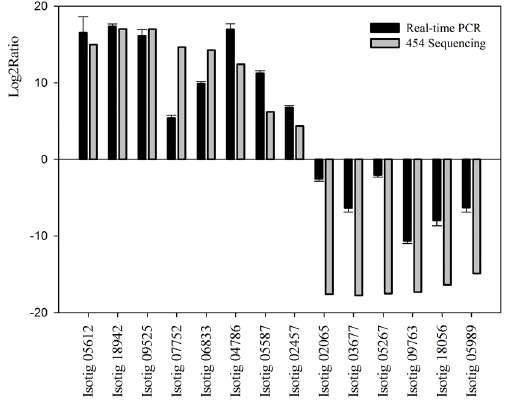
Figure 5. Histogram, comparison of gene expression between RT-PCR and 454 sequencing analysis. The RT-PCR are presented as the mean values of three repeats.